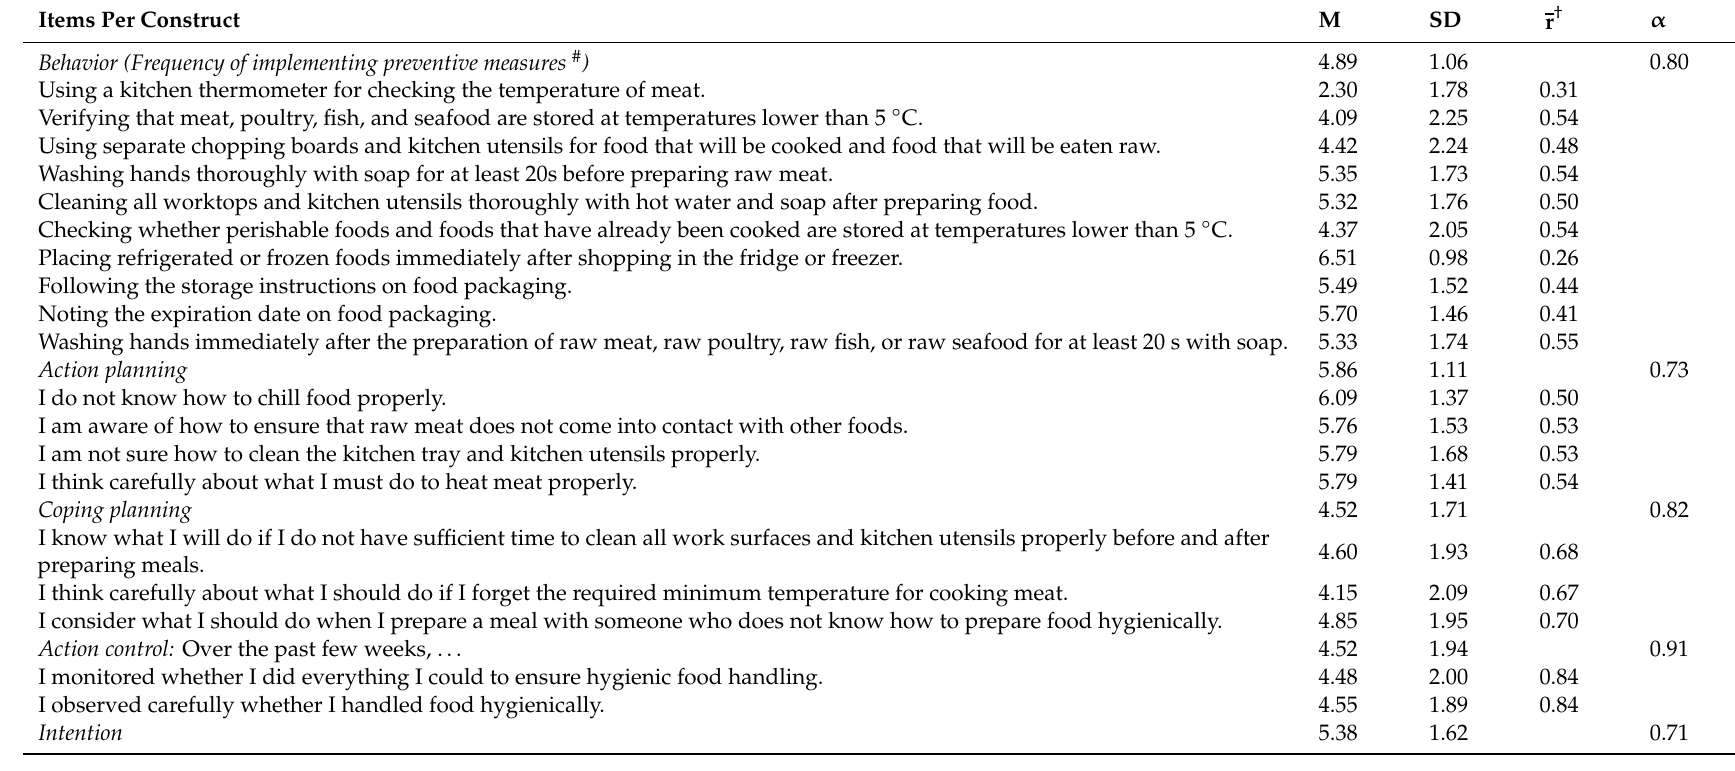
Table A2. Items, descriptive statistics, and internal reliability (Cronbach’s α ) of HAPA constructs and subjective